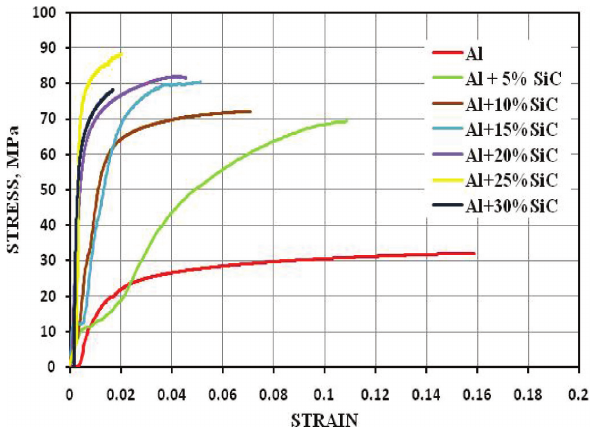
Fig. 6: Effect of adding 1 wt% Mg to Al-SiC composite on ultimate strength